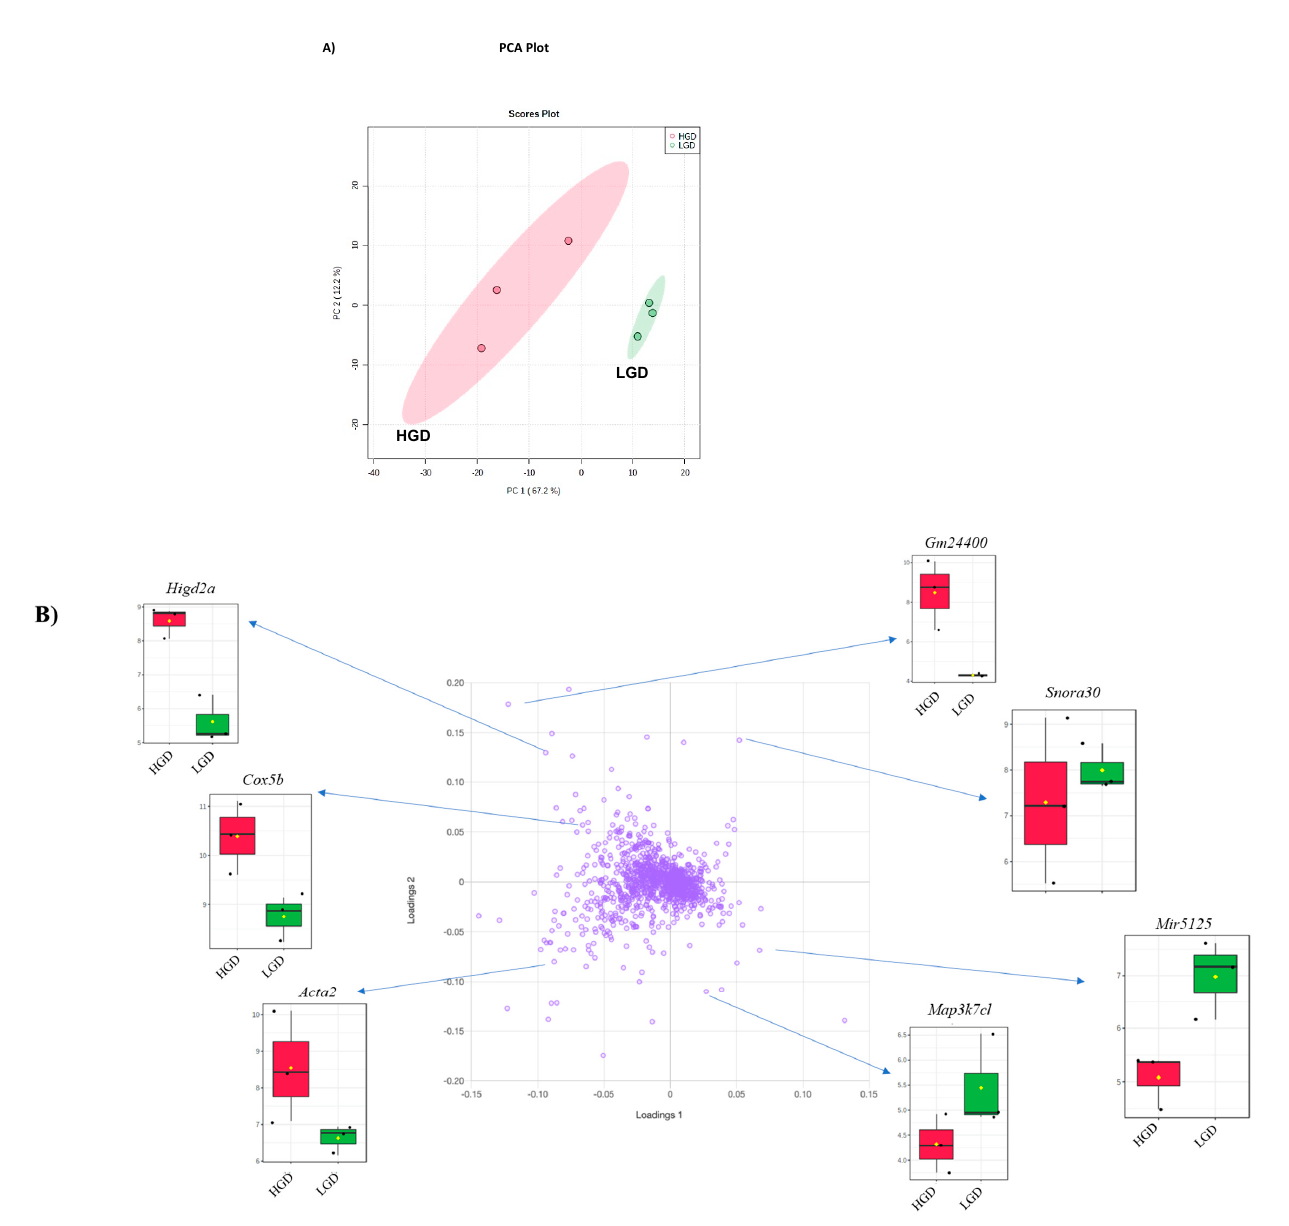
Figure 2. Principal Component Analysis (PCA) and loading plot of genes expressed in hippocampal microvessels of the high glycemic diet (HGD) and the low glycemic diet (LGD). ( A ) PCA scatter plot of the microarray data shows the trends of the expression profiles of the hippocampal microvasculature in the high glycemic diet (HGD, red circles) and low glycemic diet (LGD, green circles), respectively. The PCA plot captures the variance in a dataset in terms of principal components and displays the most significant of these on the x and y axes. The percentages of the total variation that are accounted for by the 1st and 2nd principal components are shown on the x- and y-axes labels. The data are shown for three biological replicates for each dietary group. ( B ) Loading plot of genes (violet circles) relevant to the separation of PCA. Blue arrows show box plots with expression levels of a few genes ( Higd2a, Gm24400, Snora30, Cox5b, Mir5125, Acta2, Map3k7cl, Snora30 and Map3k7cl ) that contribute to separation of the two dietary groups (HGD, LGD). In the box plots, the black dots represent gene expression levels, the notch indicates 95% confidence interval around the median of each group, and yellow diamond indicates the average gene expression of each group.